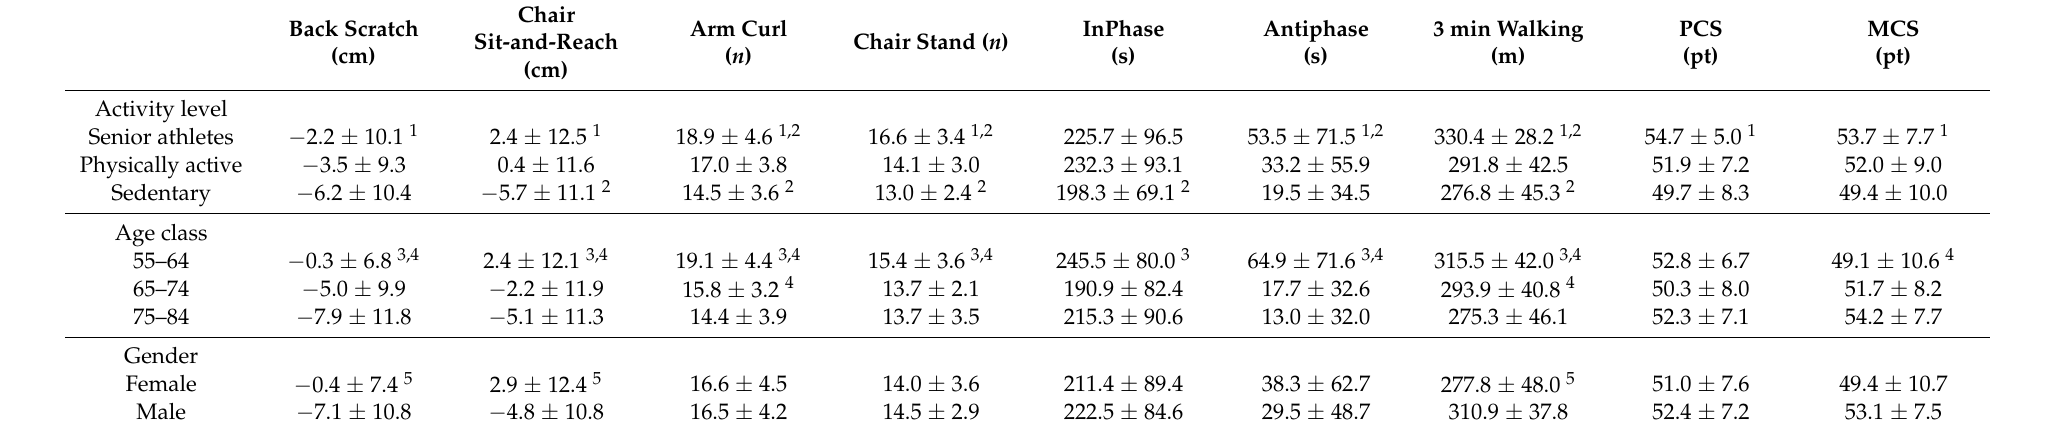
Table 2. Functional fitness and SF-12v2 indexes in relation to activity level, age class, and gender (mean ±